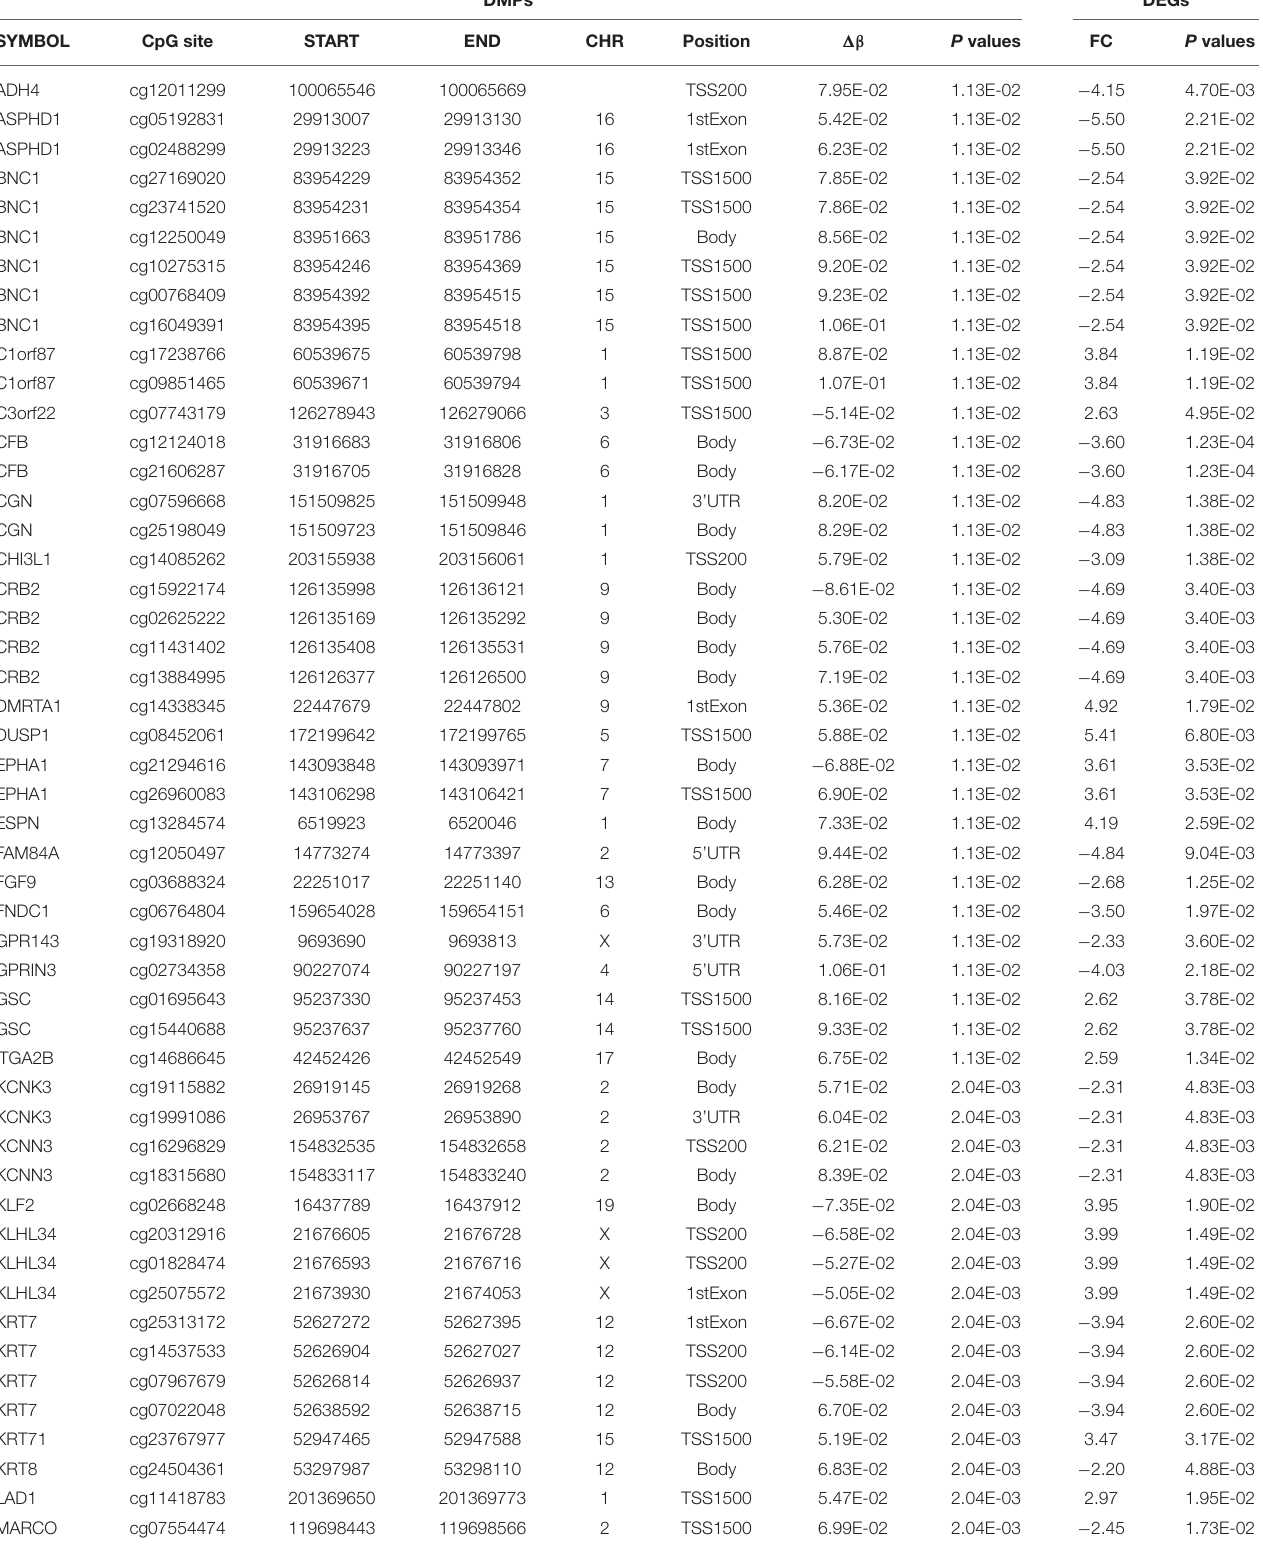
TABLE 1 | The matched pairs of DEG and